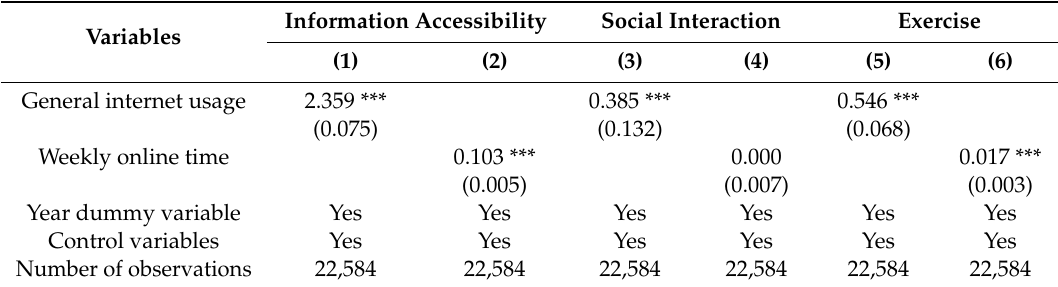
Table 3. Regression results of pathway examination.